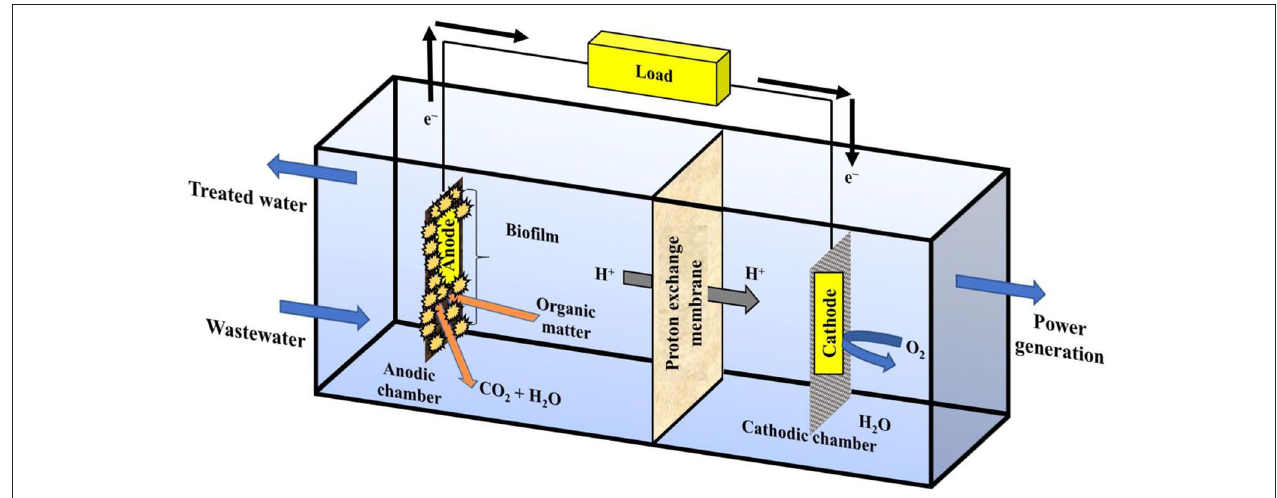
FIGURE 1 | Schematic representation of a typical microbial fuel